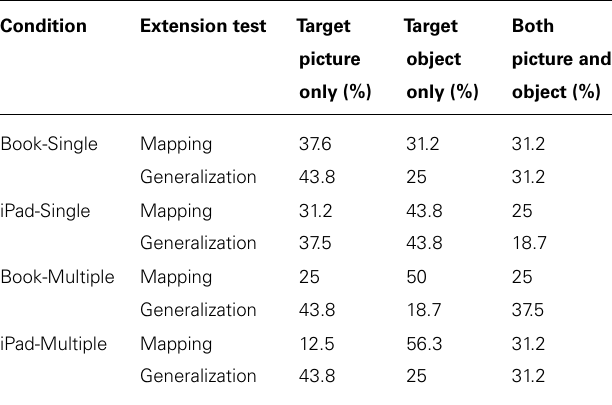
Table 1 | Participants’ responses at the MappingTest and GeneralizationTest in each condition.